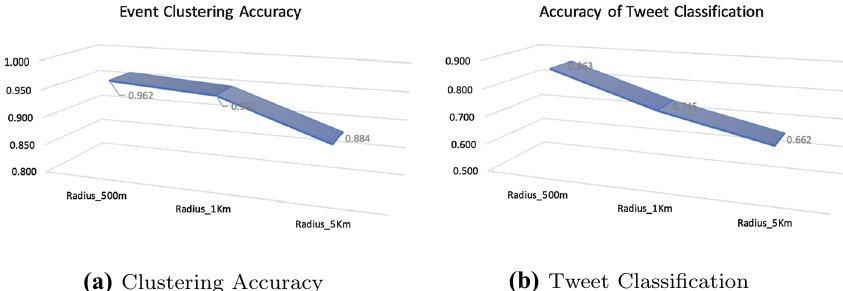
Fig. 11 Effect of varying the radius in spatial